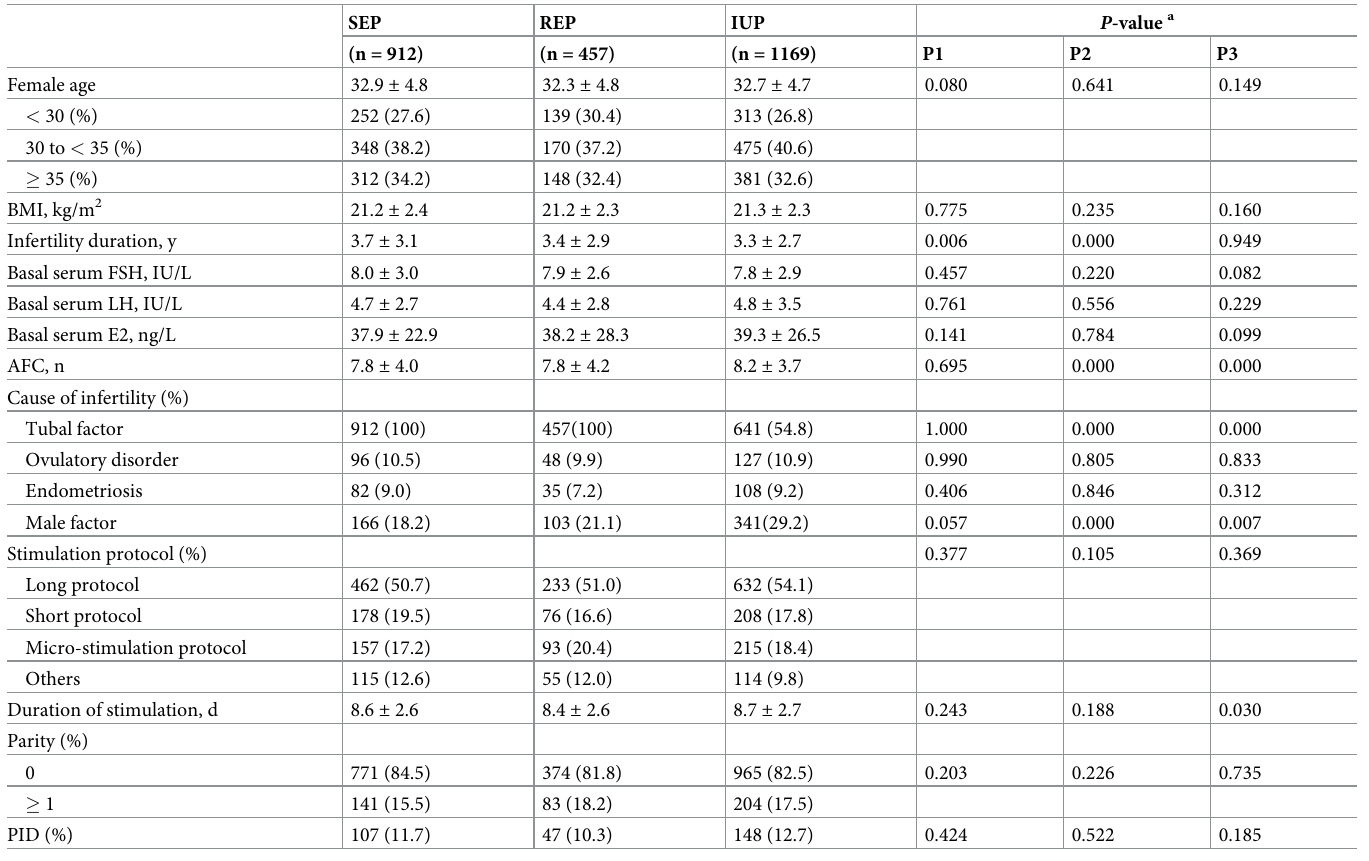
Table 1. Characteristics of patients in the three